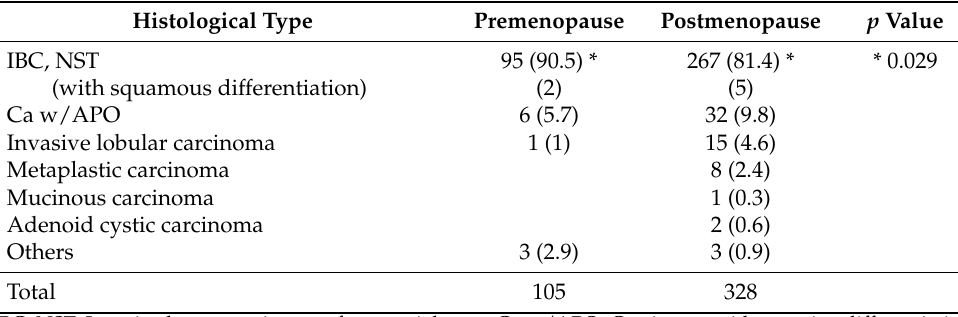
Table 3. Histological Type and Menopausal Status in